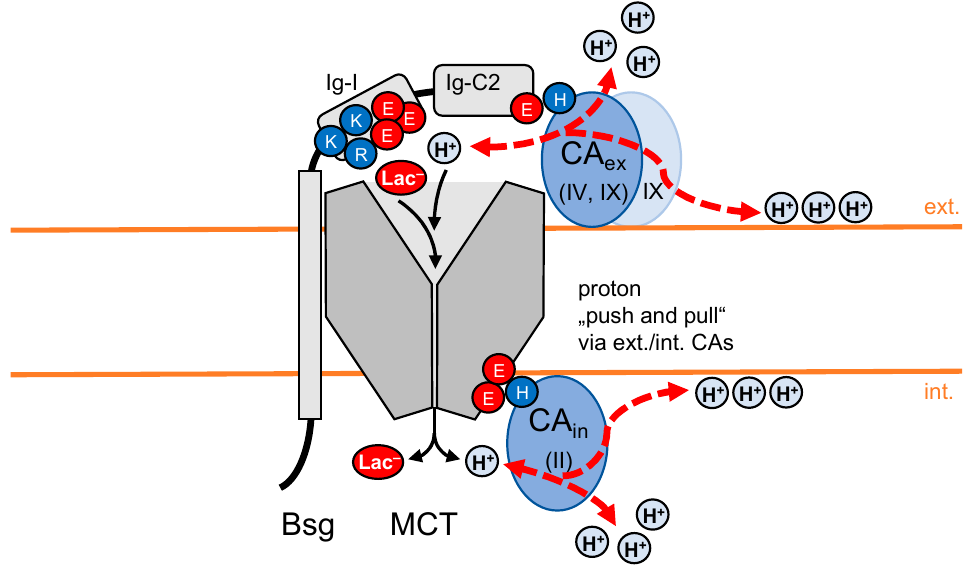
Figure 3. MCT transport supported by CA proton antennae. The extracellular isoforms CAIV or CAIX, and the intracellular CAII, contribute non-catalytically to MCT transport by channeling protons to and from the MCT entry sites according to a “push and pull principle”.